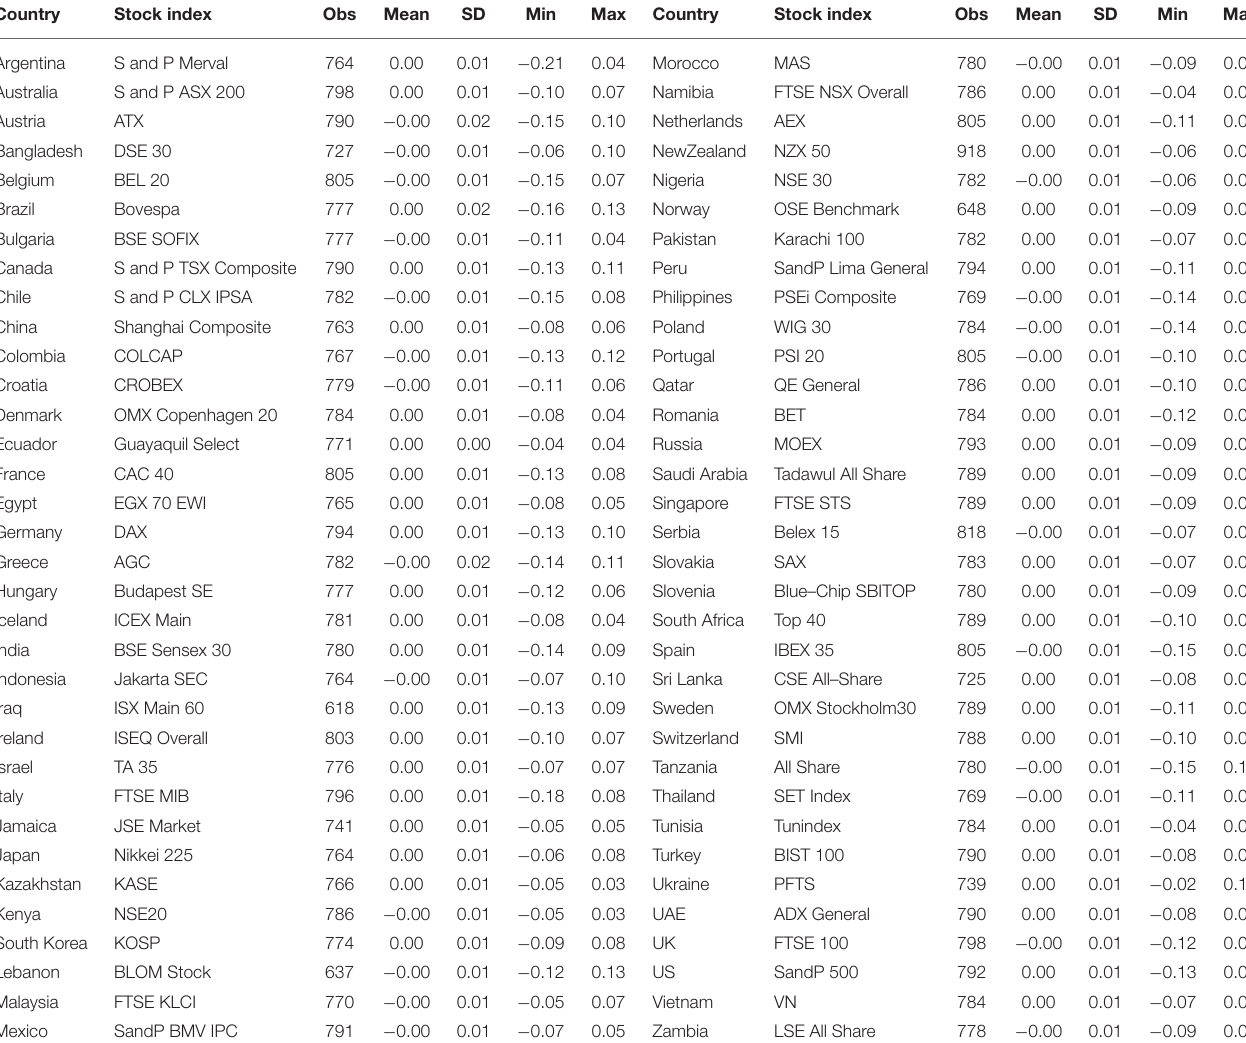
TABLE 2 | Descriptive statistics of major countries’ stock market